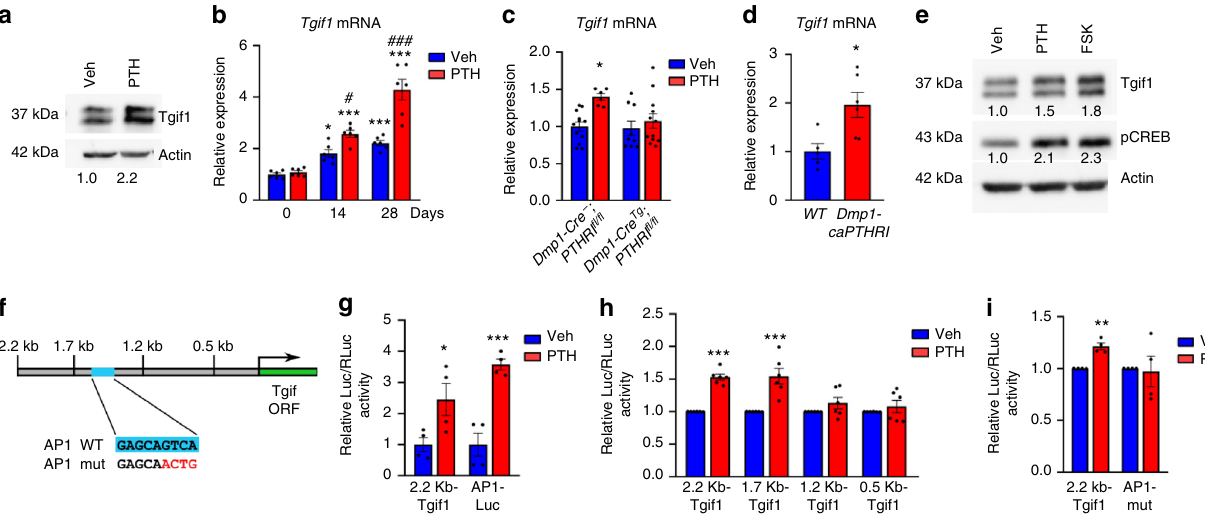
Fig. 5 Parathyroid hormone (PTH) induces TG-interacting factor 1 (Tgif1) expression through activator protein 1 (AP1). a Immunoblot of Tgif1 expression in osteoblasts upon PTH or vehicle (Veh) treatment (representative image of 4 experiments). b Tgif1 expression in differentiating SW3 cells upon PTH or Veh treatment ( N = 6, 6). c Tgif1 expression in tibiae of Dmp1-Cre Tg ;PTHR1 fl / fl mice compared to Dmp1-Cre − ;PTHR1 fl / fl control littermates after Veh or PTH injection ( Dmp1-Cre − ;PTHR1 fl / fl + Veh, PTH: N = 12, 6, Dmp1-Cre Tg ;PTHR1 fl / fl + Veh, PTH: N = 9, 12). d Tgif1 expression in tibiae of Dmp1-caPTHR1 mice compared to wild-type (WT) littermates ( N = 5, 6). e Immunoblot of Tgif1 and pCREB in osteoblasts after stimulation with PTH, Forskolin (FSK)